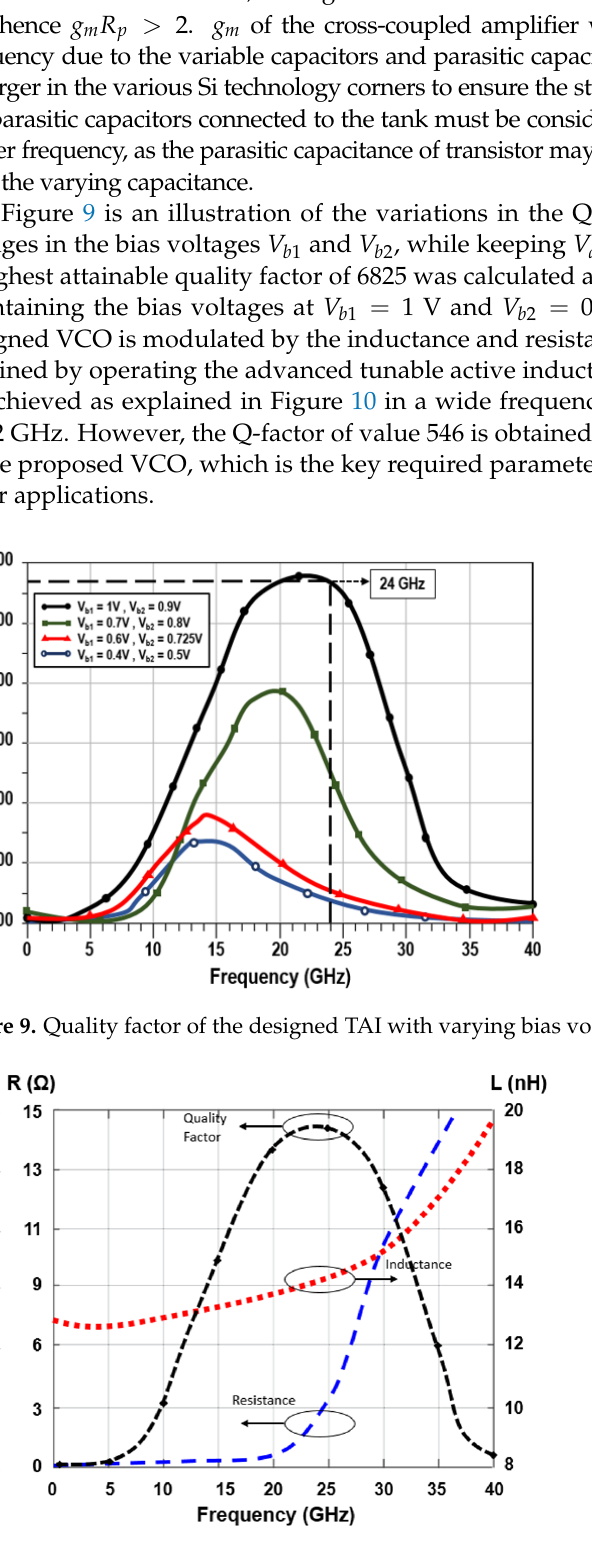
Figure 10. Quality factor of the designed